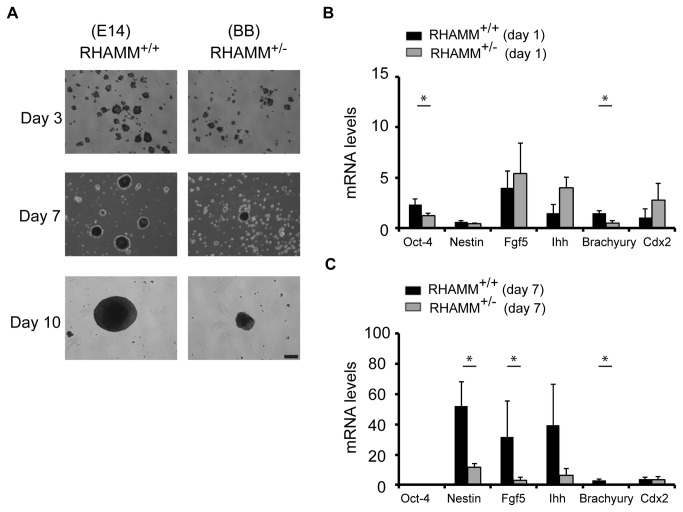
Embryoid body formation is attenuated in RHAMM+/- mouse ES cells.(A) Embryoid bodies were formed at low seeding density (2 X 104 per ml) with suspension cultures of RHAMM+/+ and RHAMM+/- mouse ES cells and imaged with brightfield microscopy through the first ten days of culture. Scale bar: 200 µm. (B) Quantitative RT-PCR for the mRNA expression of lineage differentiation markers in embryoid bodies derived from RHAMM+/+ and RHAMM+/- mouse ES cells at day 1 of culture. All expression data were first normalized to internal GAPDH control levels, and then mRNA expression levels were normalized to the respective levels in parental ES cells. Data are mean ± SE, n = triplicate experiments, * p< 0.05 for two-tailed, pairwise Student’s t test. (C) Quantitative RT-PCR for the mRNA expression of lineage differentiation markers in embryoid bodies derived from RHAMM+/+ and RHAMM+/- mouse ES cells at day 7 of culture. All expression data were first normalized to internal GAPDH control levels, and then mRNA expression levels were normalized to the respective levels in parental ES cells. Data are mean ± SE, n = triplicate experiments, * p< 0.05 for two-tailed, pairwise Student’s t test; p(Ihh) = 0.06.